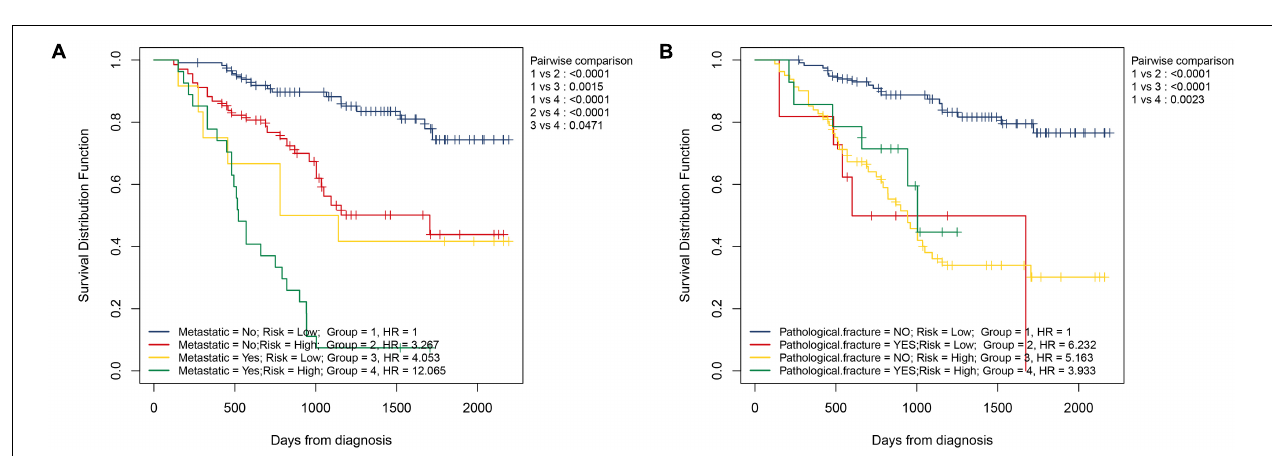
FIGURE 5 | NMRS was only associated with metastatic status. (A) Violin plots showing differences in the distribution of NMRS among patients with different metastatic status; (B) Violin plots showing differences in the distribution of NMRS among patients with different pathological fracture state; (C) Violin plots showing differences in the distribution of NMRS among patients with different tumor location; (D) Violin plots showing differences in the distribution of NMRS among patients with different gender; (E) Violin plots showing differences in the distribution of NMRS among patients with different BMI.